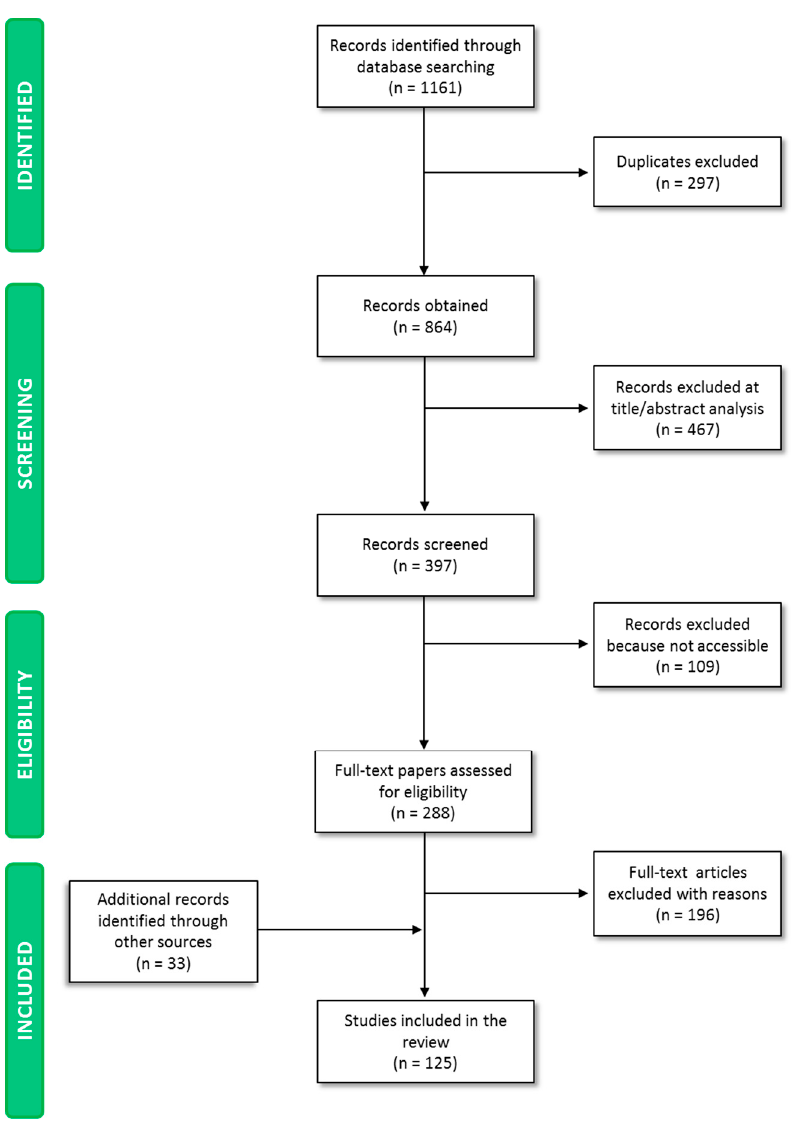
Figure 1. PRISMA (Preferred Reporting Items for Systematic reviews and Meta-Analyses).